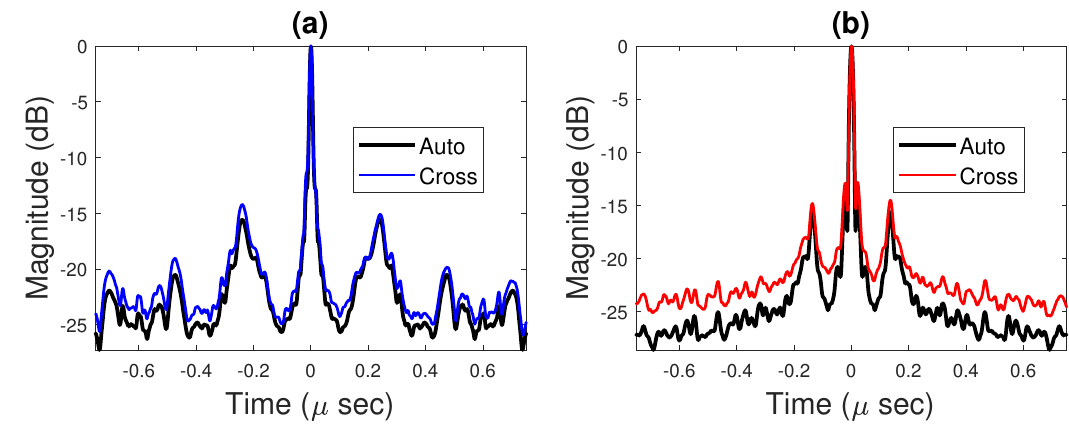
Figure 10. Auto–correlation (solid line plot) between { s ( t ) , s ( t ) } and cross–correlation between { s ( t ) , s rec ( t ) } for ( a ) the Lorenz CBFM waveform (blue color plot) and ( b ) the Burke–Shaw CBFM waveform (red color